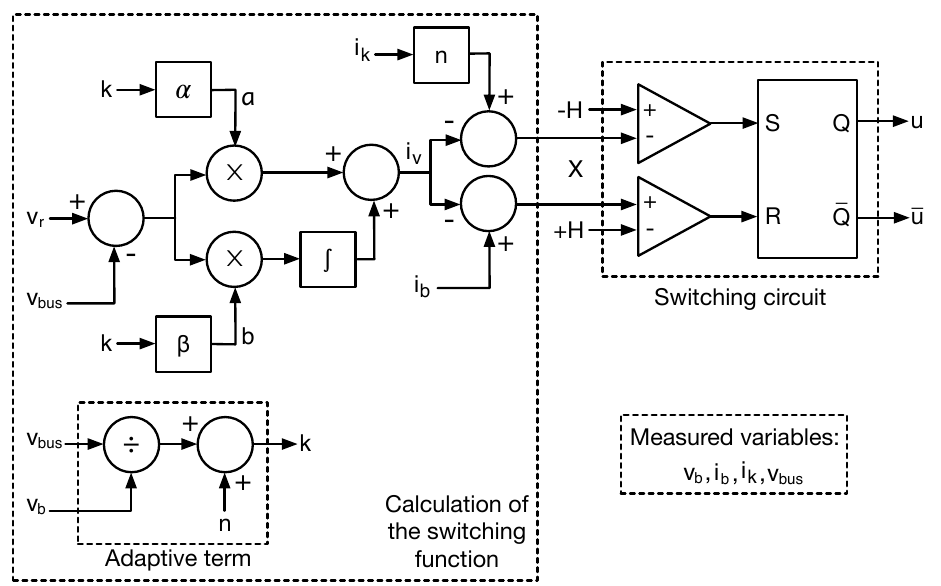
Figure 4. Practical implementation of the proposed